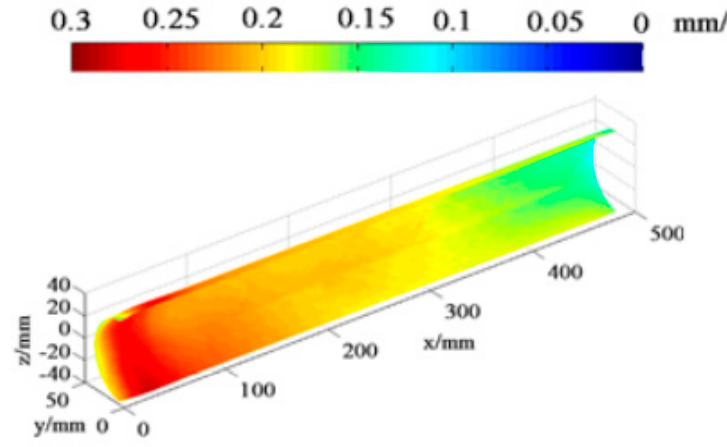
Figure 14. Regression rate contour of HDPE solid fuel grain.